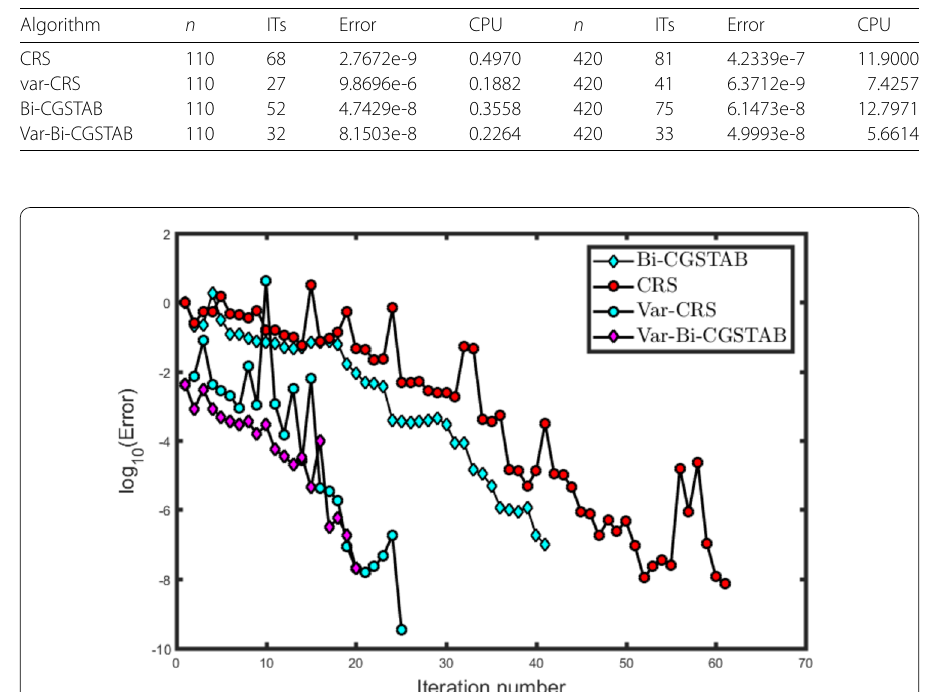
Figure 3 Comparison between the residual error of Algorithms 3 to 6 for Example